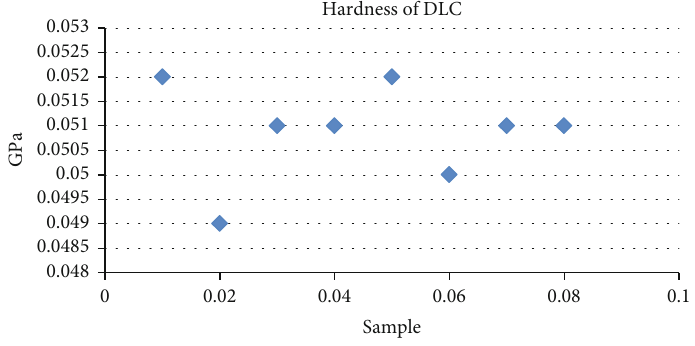
Figure 3: Hardness of